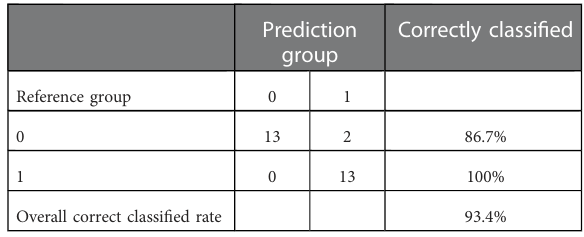
TABLE 4 Logistic regression modeling prediction